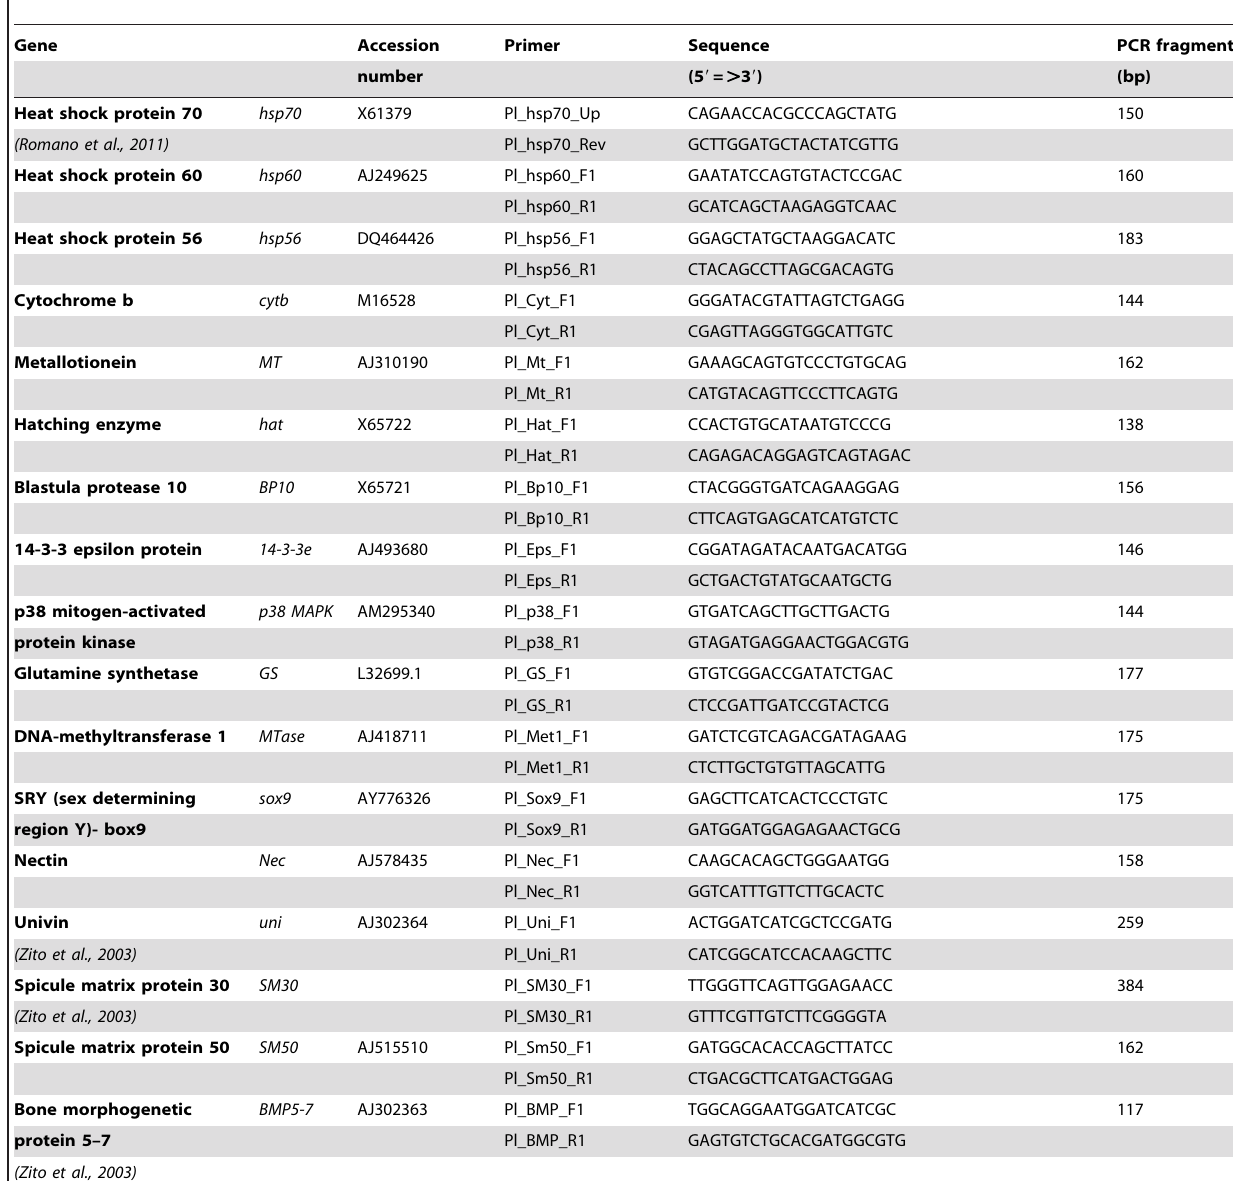
Table 1. Accession numbers, primer sequences and length of PCR amplified fragments are reported for the genes